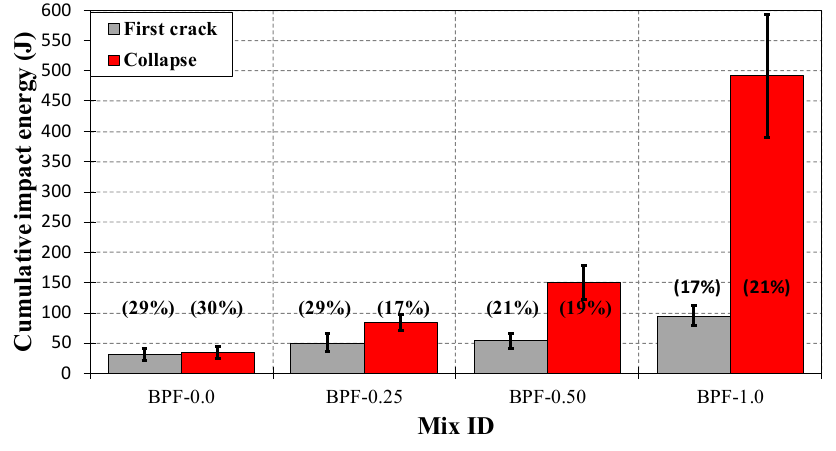
Figure 14. Impact strength for each earthen mix.